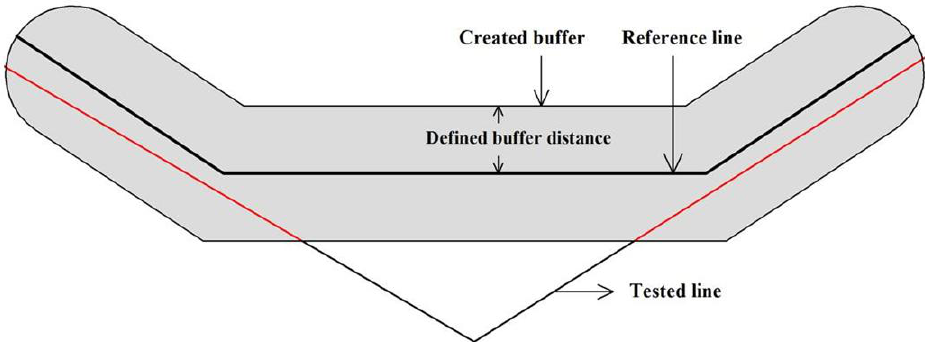
Figure 1. Increasing Buffer Method (IBM): determining the level of accuracy based on proportion of the tested line within the created buffer around the reference line